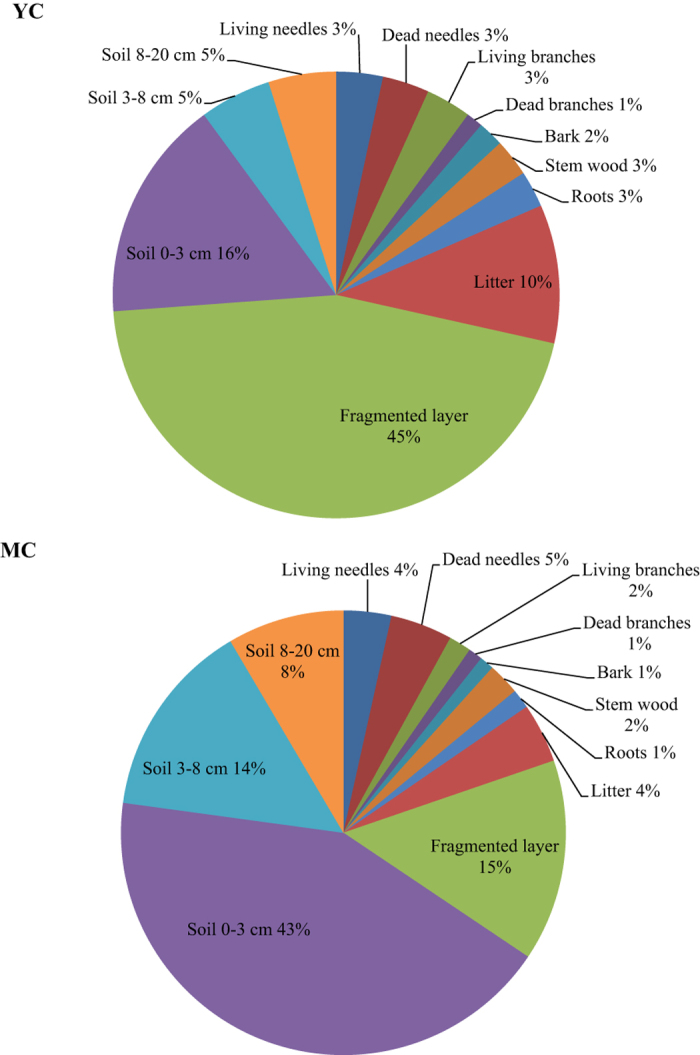
137Cs distribution in the forest compartments (%) of the forest plot YC and MC.